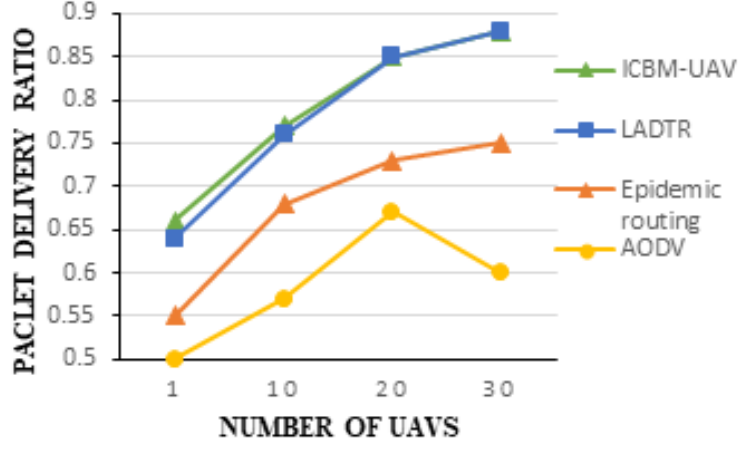
Figure 12. Packet delivery ratio without obstacles.